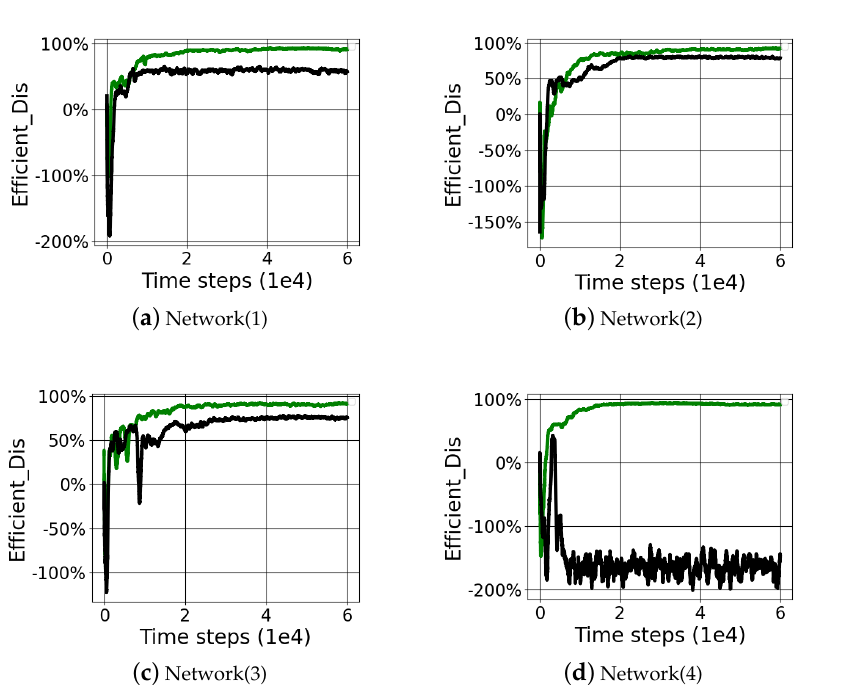
Figure 6. The efficient distances between reward function(3) (black) and reward function(4) (green) for four times of randomly initialized network node parameters as shown above in ( a – d ).